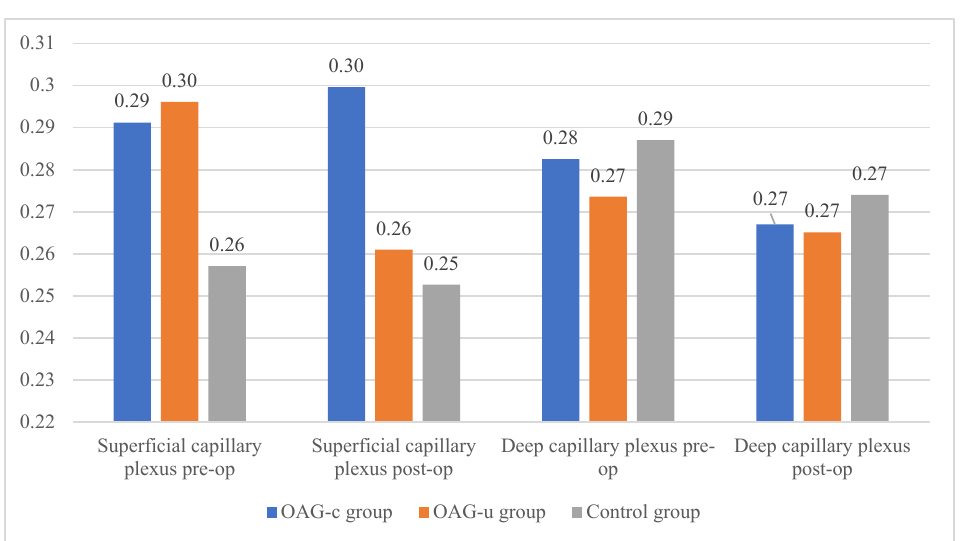
Figure 11. FAZ area of superficial and deep capillary layers before and 6 months after cataract surgery. Vertical axis shows FAZ area (mm 2 ). The horizontal measurement of the superficial capillary plexus before cataract sur ‐ gery was statistically significantly higher in the OAG c group compared to the control group ( p = 0.009). In the OAG u group the horizontal measurement before the surgery was statistically significantly higher than 6 months after surgery ( p = 0.030). The vertical meas ‐ urement before the surgery did not differ statistically significantly in all groups ( p > 0.05). In the OAG c group the vertical measurement was statistically significantly lower after the surgery than before the surgery ( p = 0.008) (Figure 12).